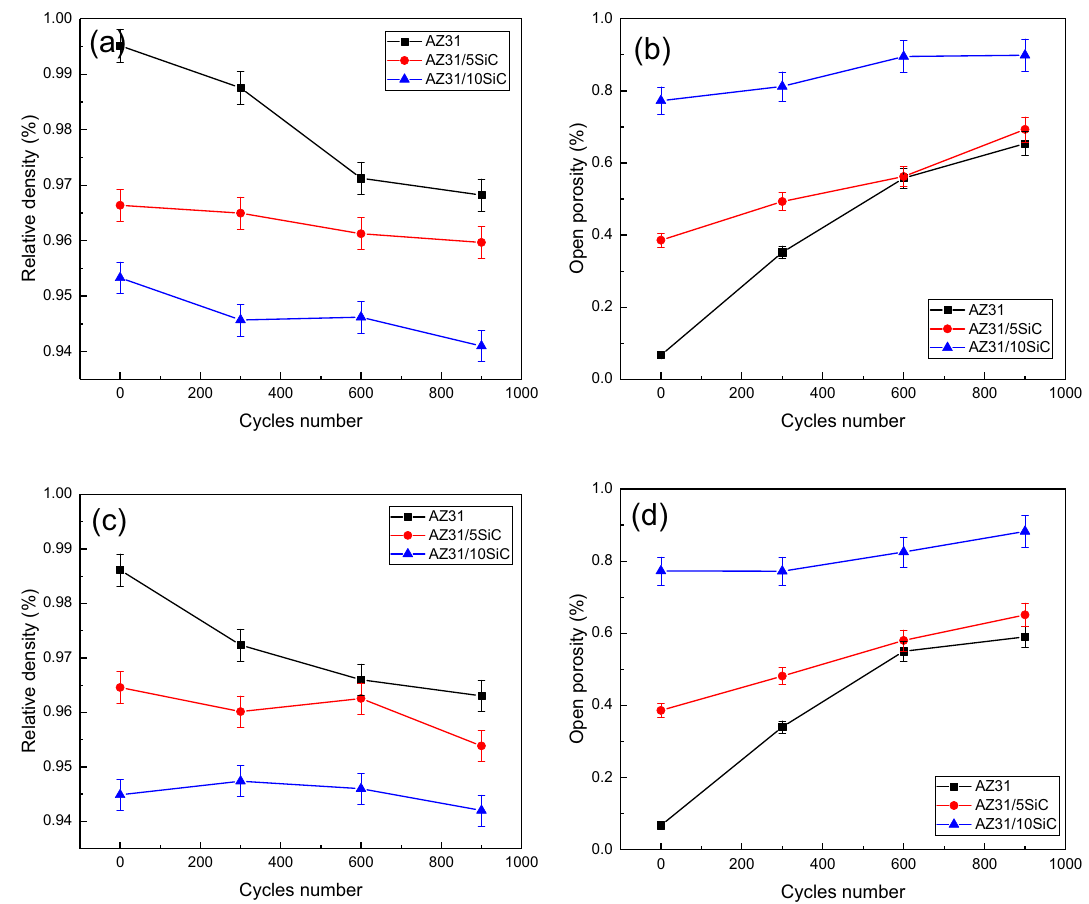
Figure 17. ( a ) Relative density of aged samples after thermal cycles at 150 °C, ( b ) open porosity of aged samples after thermal cycles at 150 °C, ( c ) relative density of aged samples after thermal cycles at 350 °C, and ( d ) open porosity of aged samples after thermal cycles at 350 °C.